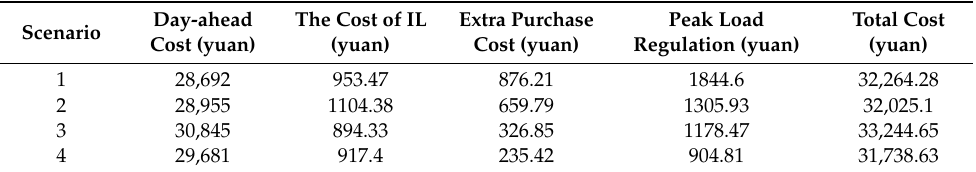
Table 2. Operating costs for each scenario.